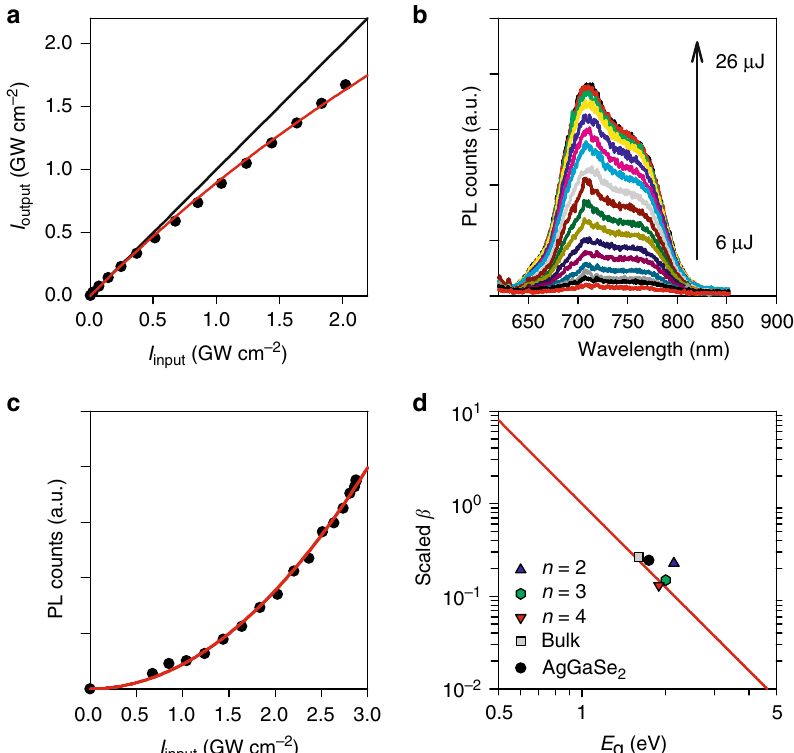
(cid:4) (cid:5) p ffiffiffiffiffi = K F 2 E 0 , vs. bandgap generated with the experimentally 0 g